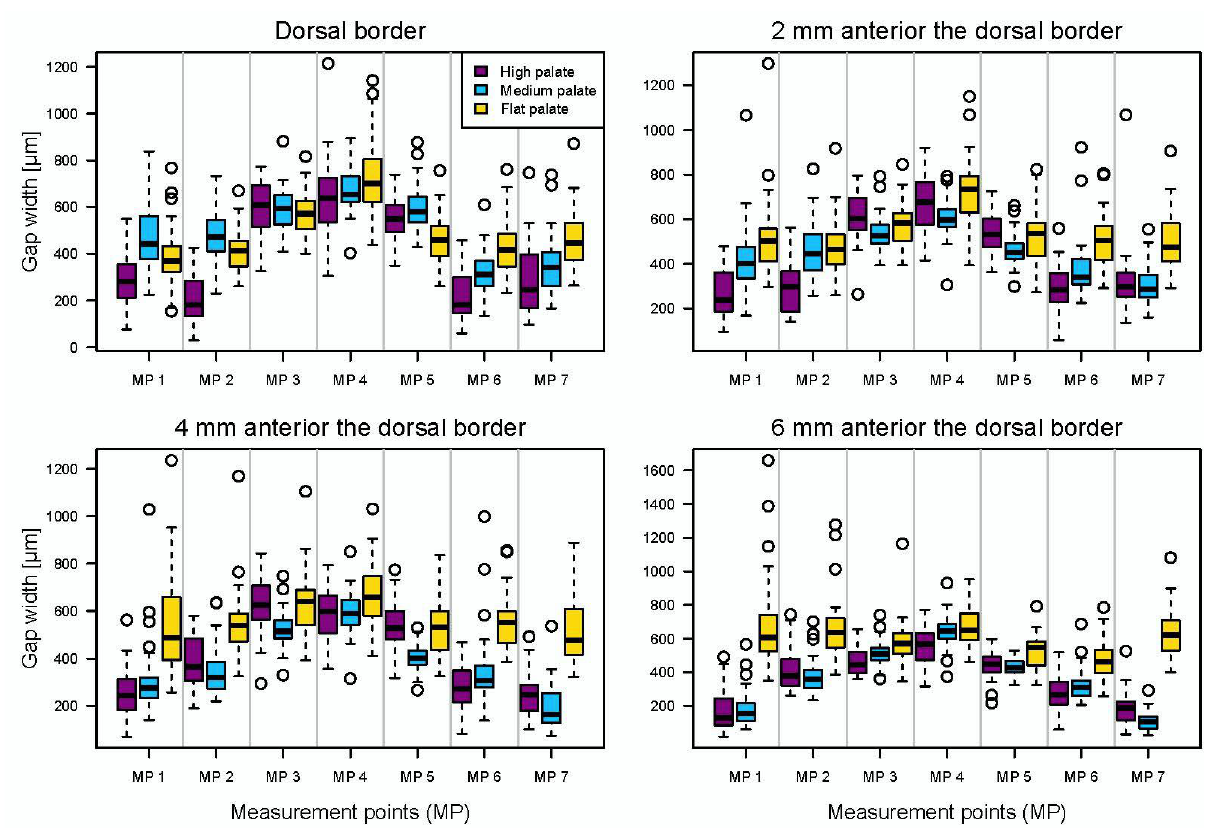
Figure 4. Boxplots of the misfits at the 7 measuring points for the 3 different shapes of palate (median, upper and lower quartile, minima and maxima) [18].